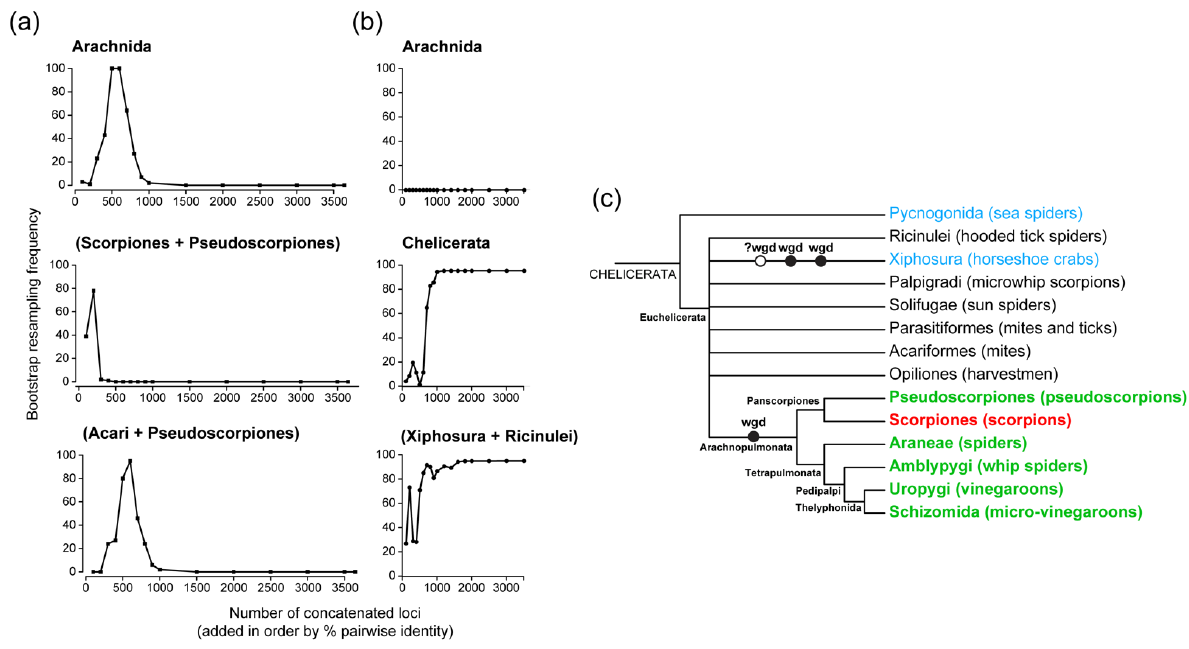
Figure 2. The ability to find localized peaks of support for nodes in slowly evolving genes is not a guarantor of phylogenetic accuracy. ( a ) Selected nodal support trajectories from Sharma et al. [17]. The bottom pair of nodes are mutually exclusive, and the bottom-most node (Acari + Pseudoscorpiones) has been falsified by rare genomic changes [10]. ( b ) Selected nodal support trajectories from Ballesteros and Sharma [41]; no support was recovered for Arachnida even among slowly evolving genes. The support trajectory for a nested placement of Xiphosura (bottom) is closely comparable to that of a robustly supported node (Chelicerata; middle). ( c ) Simplified phylogeny of Chelicerata showing inferred locations of whole genome duplications (WGD). Note that no morphological phylogeny has ever recovered this composition of Arachnopulmonata. Colors in ( c ) follow Figure